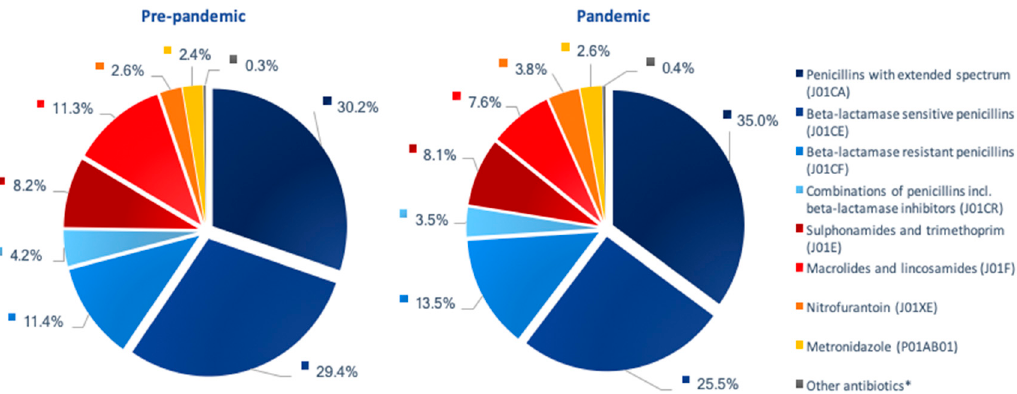
Figure 2. Prescribing of antibiotic agents based on ATC-groups **. * Other antibiotics include tetracyclines (J01AA), cephalosporins (J01D), fluoroquinolones (J01MA), polymyxins (J01XB) and methenamines (J01XX). ** Both piecharts contain identical groups and are directly